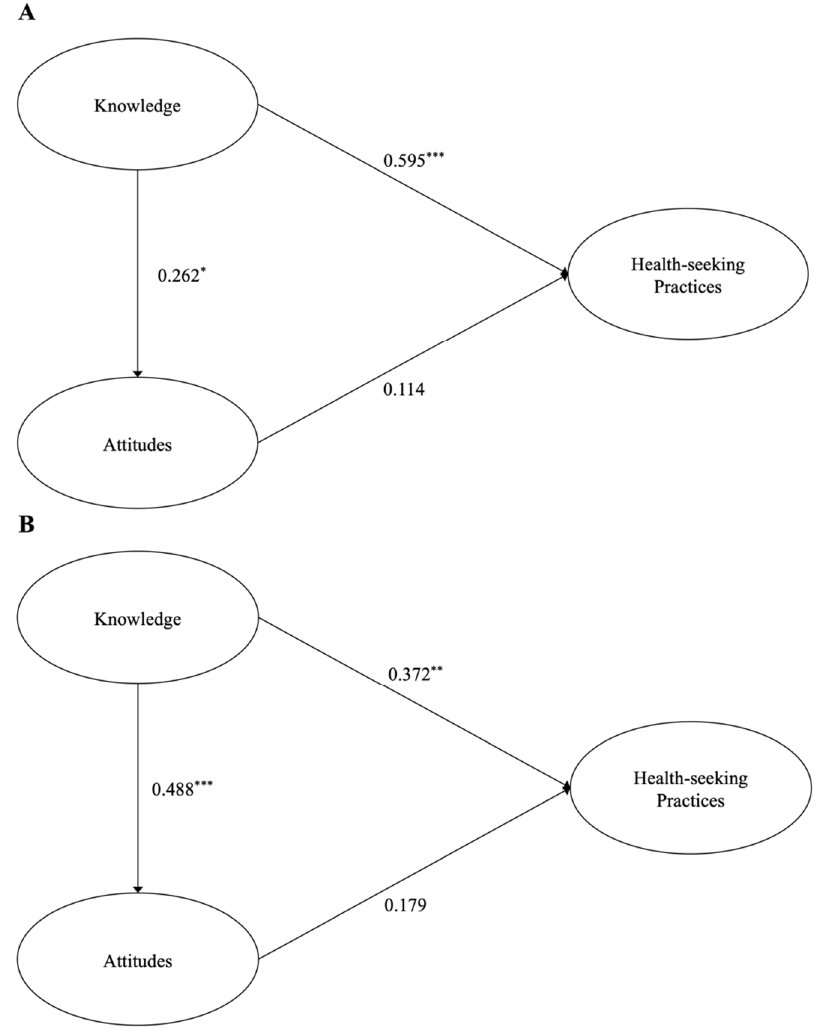
Figure 2. Results of the structural model using a path analysis for facility manager ( A ) and healthcare professionals ( B ). Asterisk indicates a statistical significance; ***: p < 0.001, **: p < 0.01, *: p < 0.05.